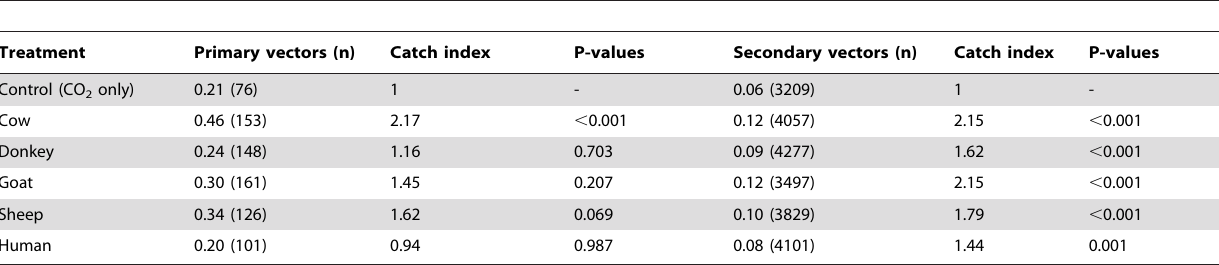
Table 1. Proportion of engorged RVFV mosquito (blood fed + gravid) of total captures recorded in control traps (CO 2 only) and combined lures having CO 2 and crude skin odors from the different hosts evaluated with corresponding catch indices.